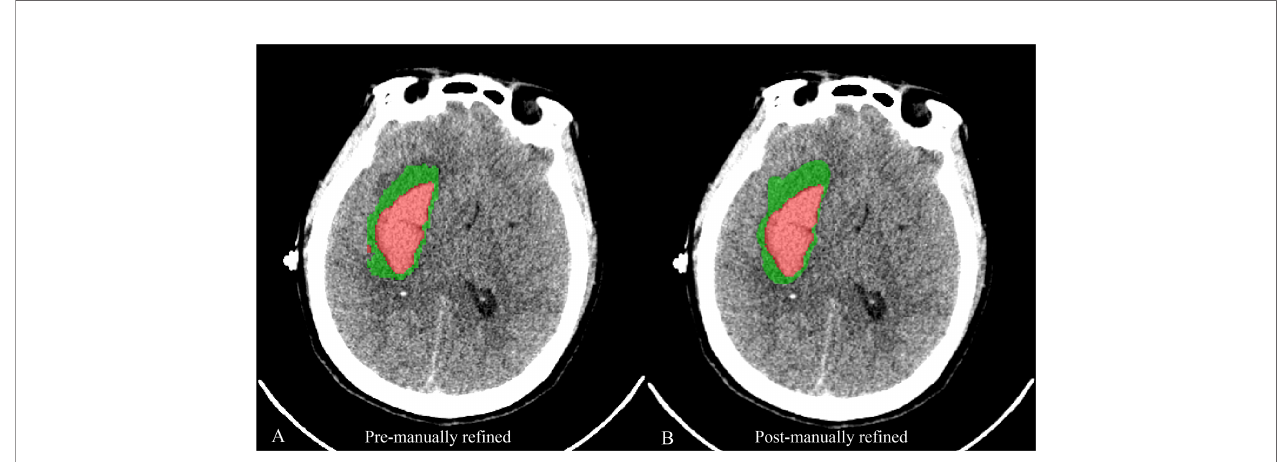
FIGURE 3 | A case reveals the image of automatic segmentation for hematoma (red) and PHE (green) (A) and the corresponding image of segmentation being manually re fi ned (B)